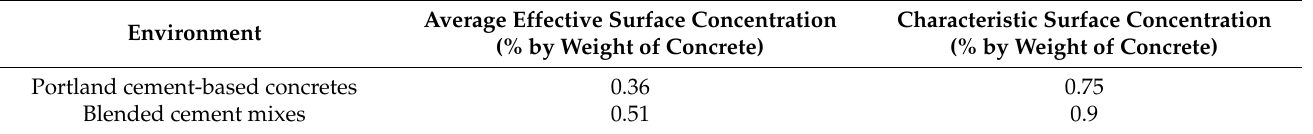
Table 2. Peak values for effective surface